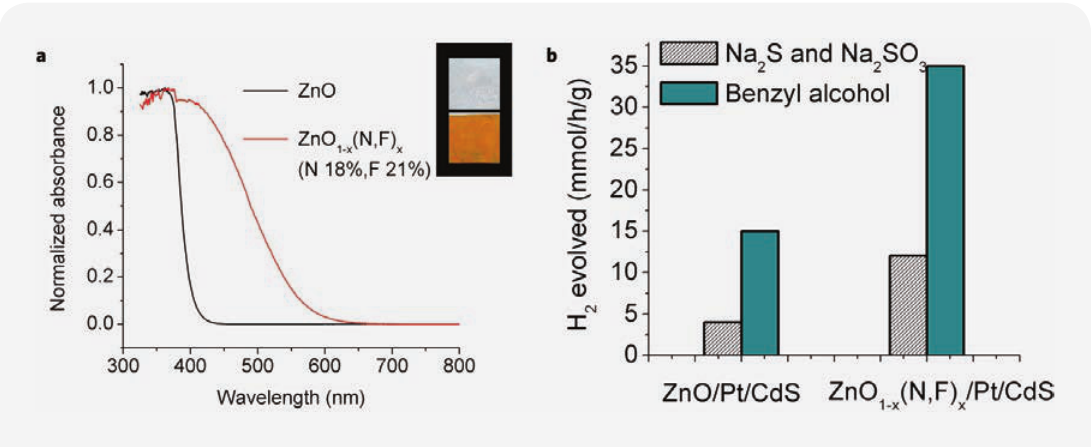
Figure 6. (a) Comparison of electronic absorption spectra of ZnO 1_x (N,F) x nanostructures and ZnO and (b) comparison of effect of co-doping of N and F in ZnO on hydrogen evolution of ZnO/Pt/CdS using Na 2 S and Na 2 SO 3 or benzyl alcohol–acetic acid mixture under visible light irradiation. Reproduced with permission from Ref. 7.